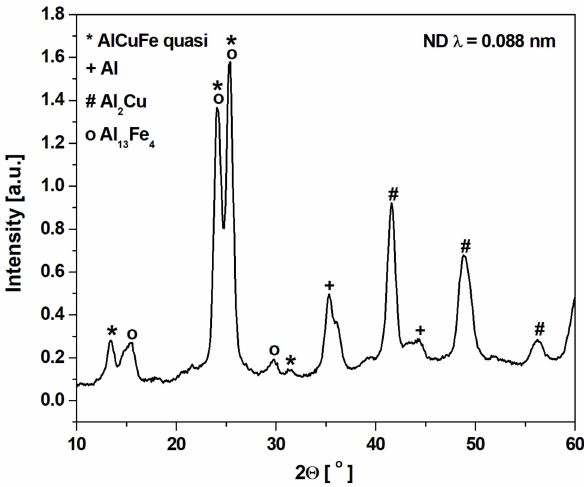
Figure 2. Neutron diffraction (ND) pattern of Al 65 Cu 20 Fe 15 alloy in the form of a